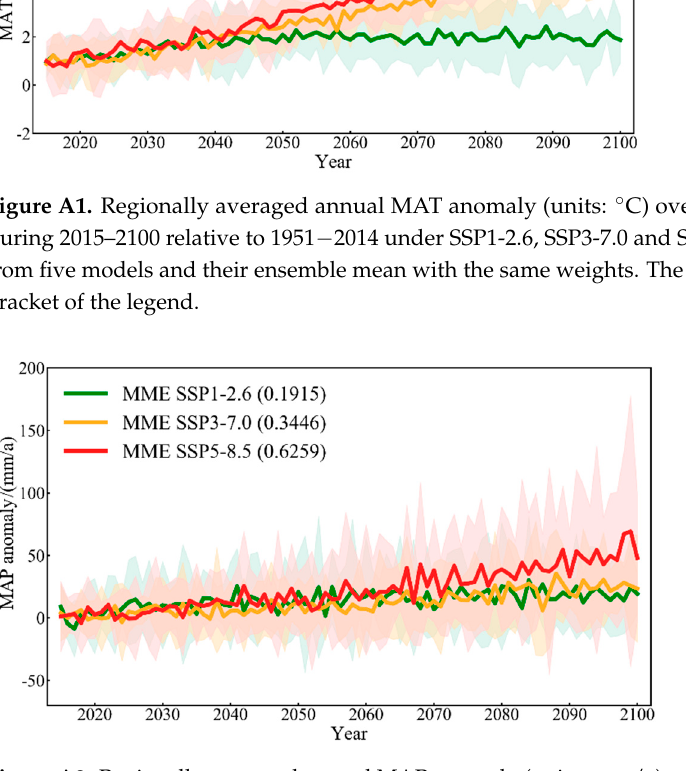
Figure A2. Regionally averaged annual MAP anomaly (units: mm/a) over the Qinghai-Tibet Plateau during 2015–2100 relative to 1951–2014 under SSP1-2.6, SSP3-7.0 and SSP5-8.5 scenarios as derived from five models and their ensemble mean with the same weights. The tendency rate of is shown in bracket of the legend.